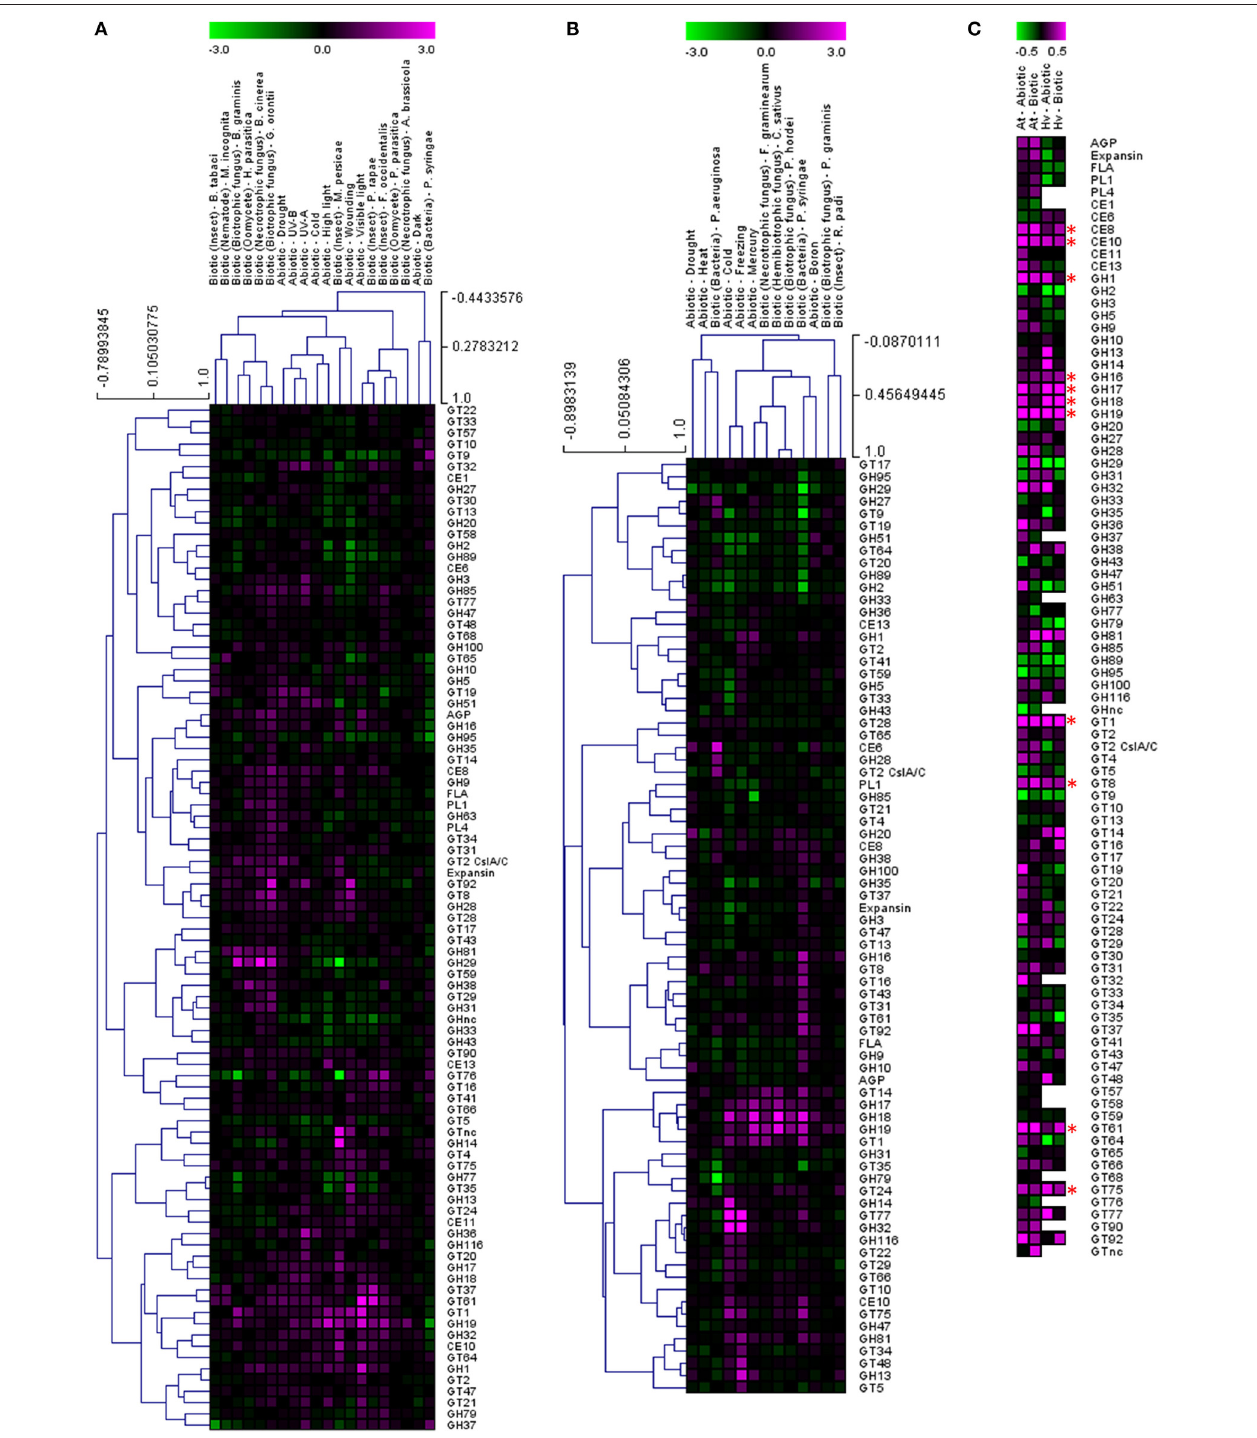
FIGURE 1 | Analysis of cell wall-related transcripts following abiotic and biotic stresses in Arabidopsis (A) and barley (B). Transcript abundance was determined through meta-analysis of microarray datasets collected from the Plant Expression Database (PLEXdb; Dash et al., 2012) using the experiments listed in Table 2 . Values show the average log(2)-fold induction for representatives of each CAZy gene family present on the Arabidopsis Affymetrix 22K ATH1 genome array and the 22K Barley1 genechip. Hierarchical clustering was performed based on the Pearson correlation coefficients across each dataset and CAZy family. Trends conserved in response to the stresses between Arabidopsis and barley are observed in (C) which shows the average fold induction for each gene family for all abiotic and all biotic stresses in Arabidopsis and barley. Asterisks indicate gene families for which expression is upregulated by both abiotic and biotic stresses in Arabidopsis and